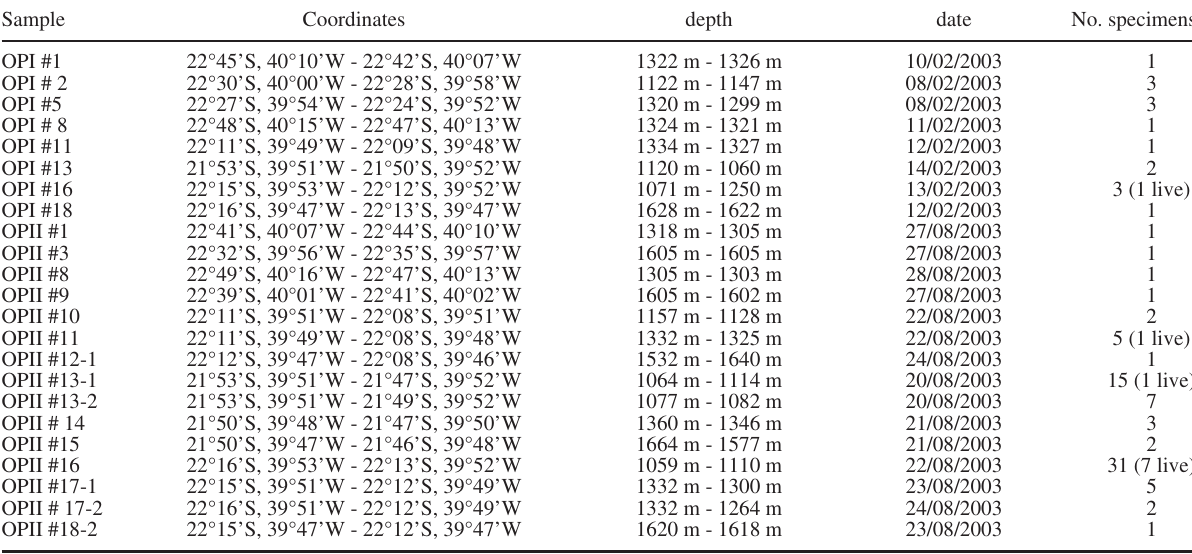
Pleurotoma macra : Dautzenberg and Fischer (1906: 12). Pleurotoma ( Pleurotomella ) macra : Dautzenberg (1927: 57, pl. II, Fig. 5). Benthomangelia macra : Bouchet and Warén (1980: 46, Fig. 104- 105, 212-213); Rios (1994: 173, pl. 57, Fig. 792; 2009: 338, species 870).